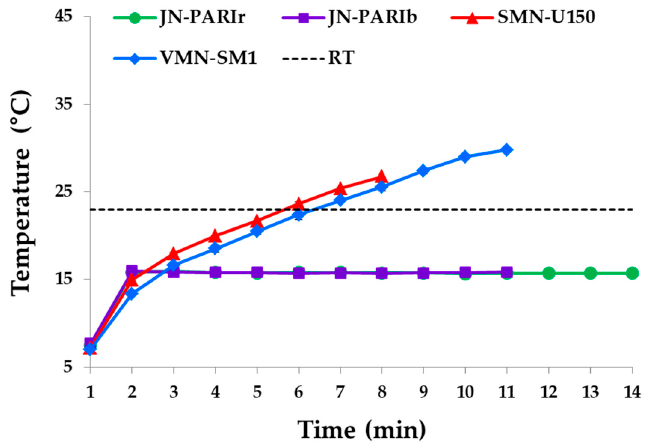
Figure 3. Plot of reservoir temperatures during nebulization by the JN-PARIr ( green circle line ), JN-PARIb ( purple square line ), SMN-U150 ( red triangle line ), and VMN-SM1 ( blue diamond line ) nebulizers. The black dashed lined indicates room temperature (RT).